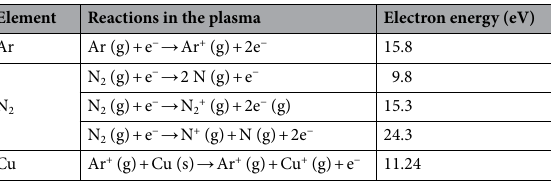
Table 4. Main reactions for each element in the plasma and required electron energy 36,39